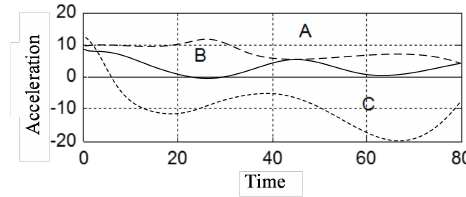
Figure 2 .DTW Optimal Path